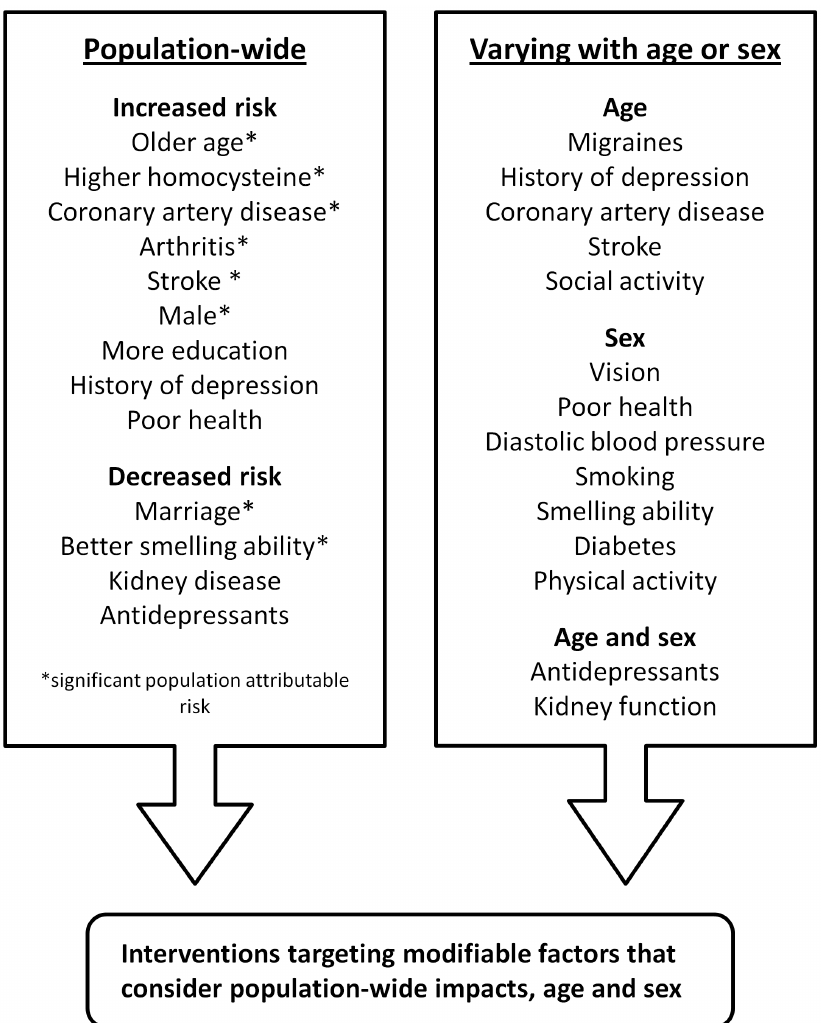
Figure 1. Factors associated with cognitive decline. Interventions modifying factors with a significant population attributable risk might greatly reduce population-wide cognitive decline. Age and sex interactions suggest further benefits by tailoring interventions to particular demographic groups.